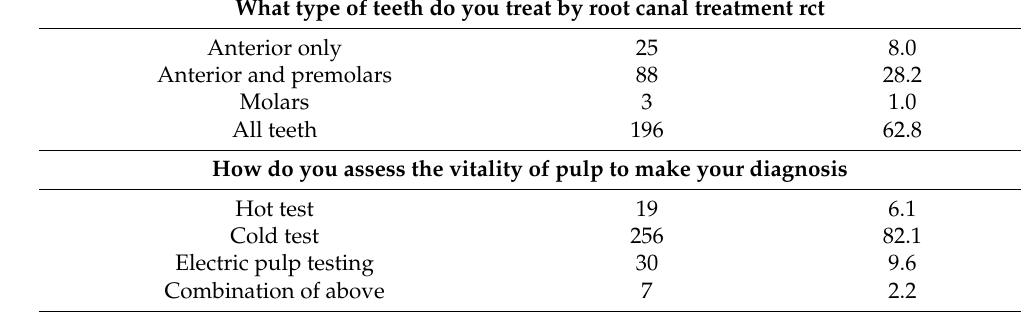
Table 2. Use of various instruments and materials for cleaning, shaping, and obturation in various steps of root canal treatment